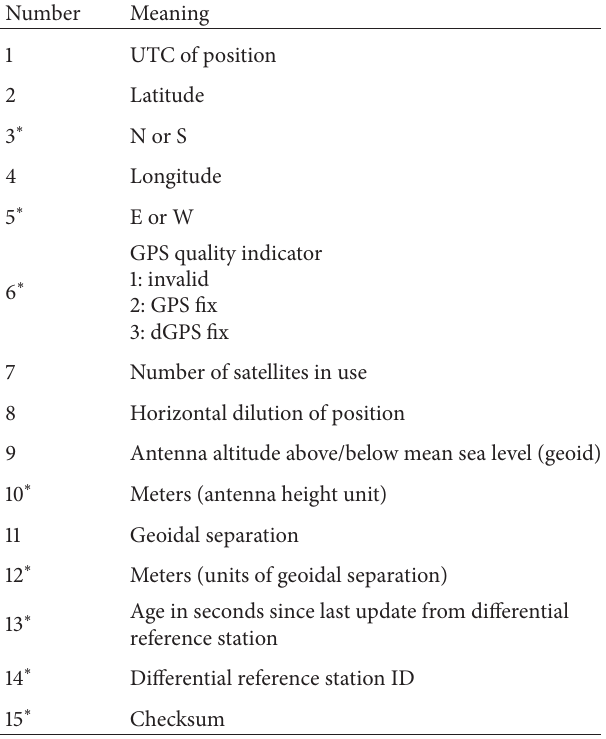
Table 1: Fifteen fields of GPGGA sentence.